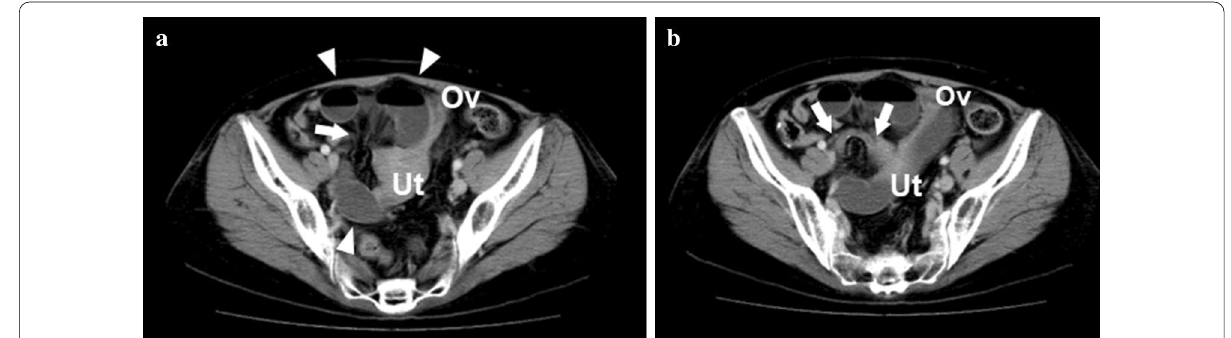
Fig. 2 Contrast-enhanced computed tomography (CT) findings. Small-bowel loops (arrowheads) were dilated in the vicinity of the uterus and the mesentery converged at the right side of the uterus (arrow). The uterine showed counterclockwise rotation ( a ). The next slice of A revealed a thick band (arrows) interpolated in the convergence of the mesentery ( b ). Ut and Ov indicate uterine and left ovary,